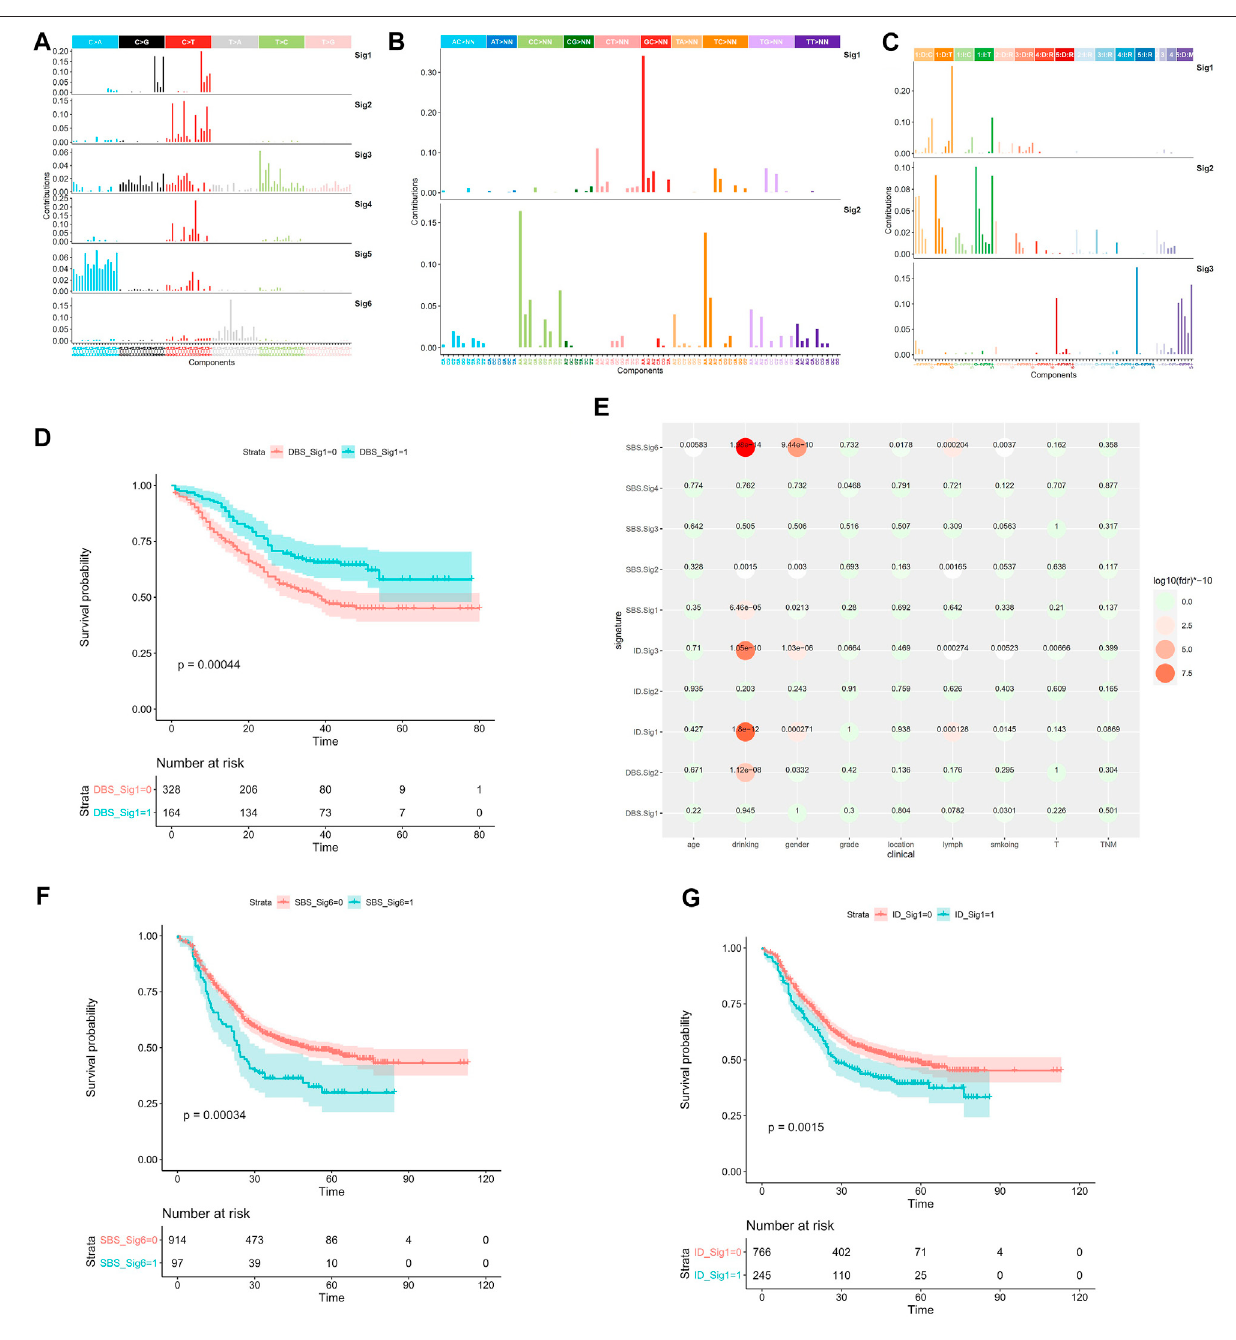
Frontiers in Molecular Biosciences |